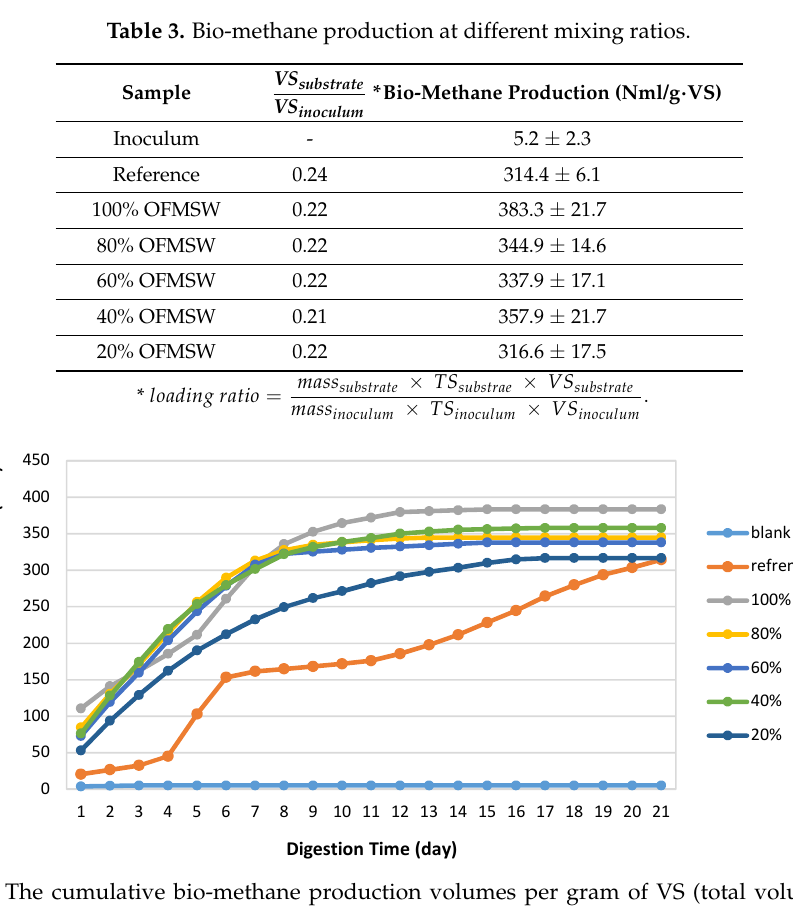
Figure 1. The cumulative bio-methane production volumes per gram of VS (total volumes were recorded by the automated methane potential test system (AMPTS), then divided by the VS